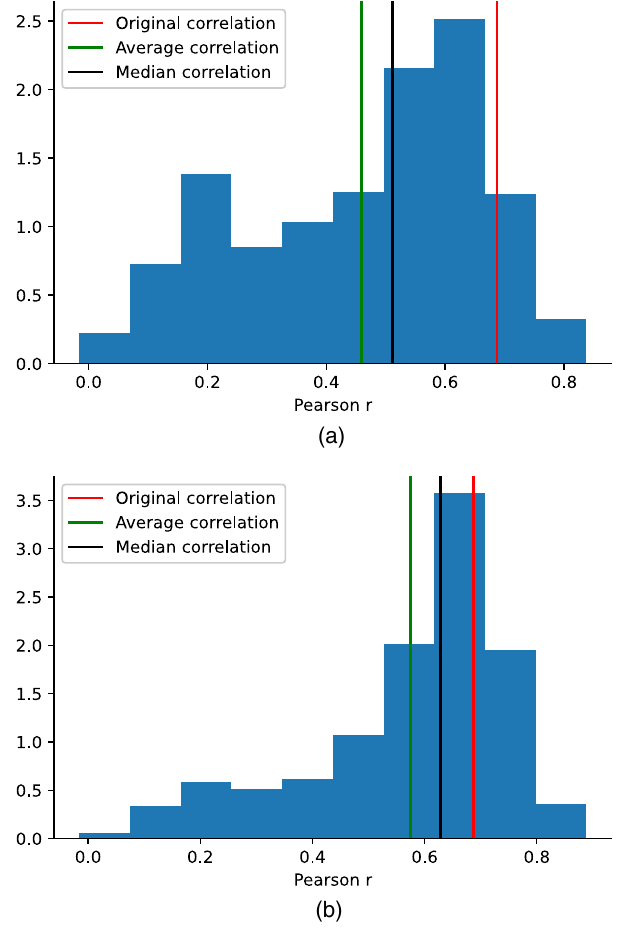
FIG. 9. Histogram of correlations between grades and inward harmonic centrality, c Hi , in networks created by dropping nodes from the full Mines network. The red lines in each plot represent the correlation between grades and inward harmonic centrality measured in the original Mines network. The green and black lines represent the mean and median correlation of the ensemble of reduced networks. The blue bars represent the histogram of correlations calculated from the networks in the ensemble. (a) Histogram of correlations in reduced networks created by preferentially dropping nodes with low grades from the Mines network, and (b) Histogram of correlations in reduced networks created by preferentially dropping nodes with low centrality from the Mines